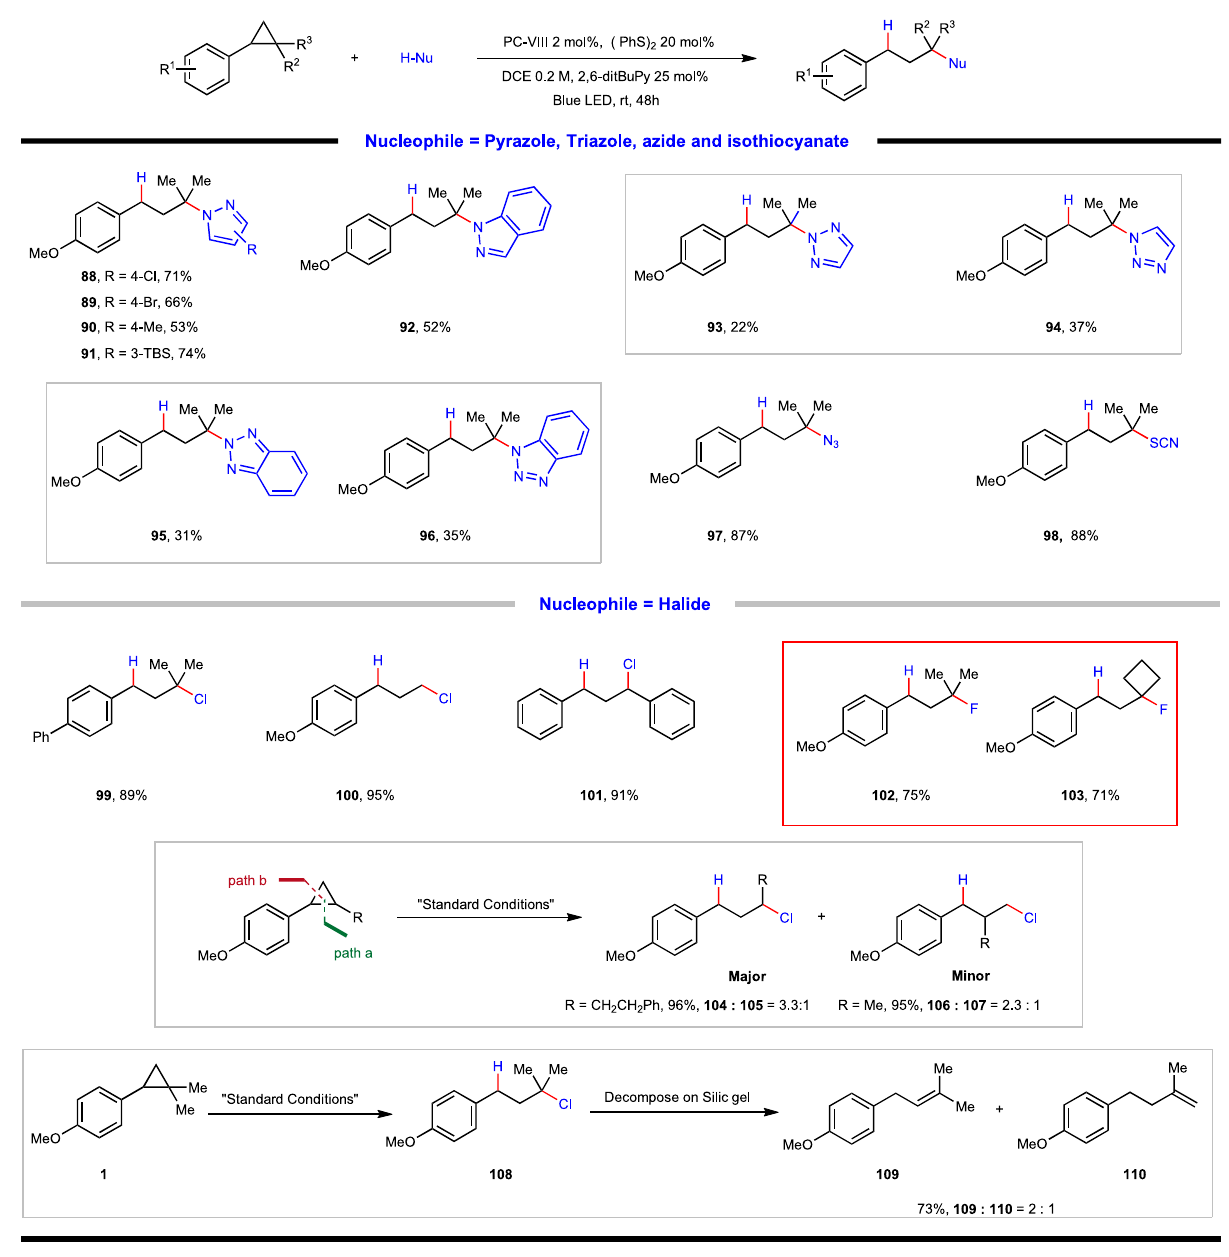
Fig. 5 | Substrate scope of photoredox-coupled C( sp 3 ) – heteroatom bond for- mation with other hetero-nucleophiles. 88 – 96 : arylcyclopropane (0.2mmol, 1 equiv.), heterocycle (1.5 equiv.), photocatalyst (2mol%), (PhS) 2 (0.04mmol, 0.2 equiv.), 2,6-ditBu-Py (0.05mmol, 0.25 equiv.) and DCE (1.0mL, 0.2M) at 25°C